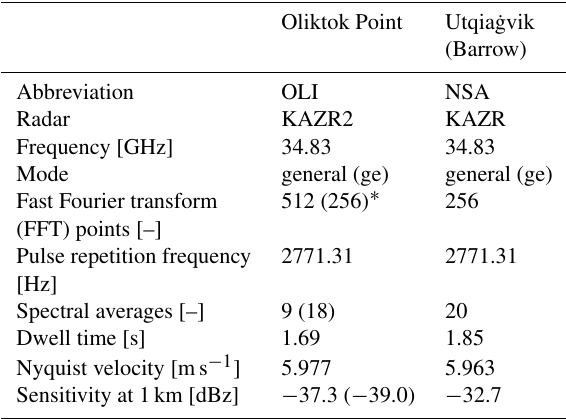
Table 1. Technical specifications of the radars at Oliktok Point and Utqia˙gvik